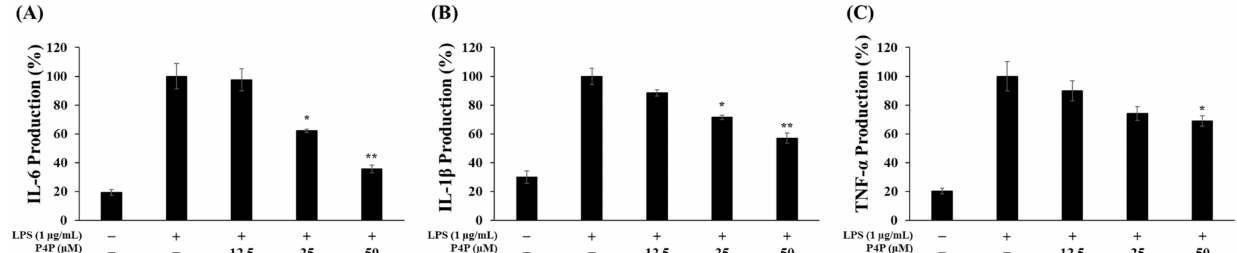
Figure 3. Effect of P4P on the ( A ) IL6, ( B ) IL1 β , and ( C ) TNF α production in LPS-stimulated RAW 264.7 cells. Cell were treated with LPS (1 µ g/mL) in the presence/absence of P4P (0.01% DMSO) for 24 h. Their production was determined by ELISA. The values of triplicate experiments are represented as the mean and standard deviation (SD). * p < 0.05 and ** p < 0.01 versus LPS alone.